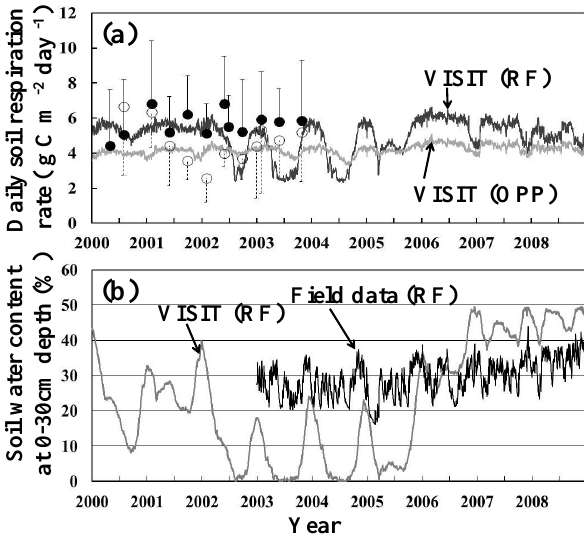
Fig. 8. Comparisons of the VISIT model simulation and field mea- surements of (a) soil respiration rates (SR) in the rainforest (RF) and oil palm plantation (OPP) from 2000 to 2004 and (b) daily mean soil water content at 0- to 30-cm depth in RF from 2003 to 2008. In (a) , model simulation for RF (bold line), model simula- tion for OPP (gray line), observed mean SR in RF (filled circles), observed mean SR in OPP (open circles); error bars show the stan- dard deviation ( n = 16). See Adachi and Koizumi (2009) for field measurements. In (b) , field observation from Kosugi et al. (2009) (bold line) and VISIT model estimates in RF (gray line).